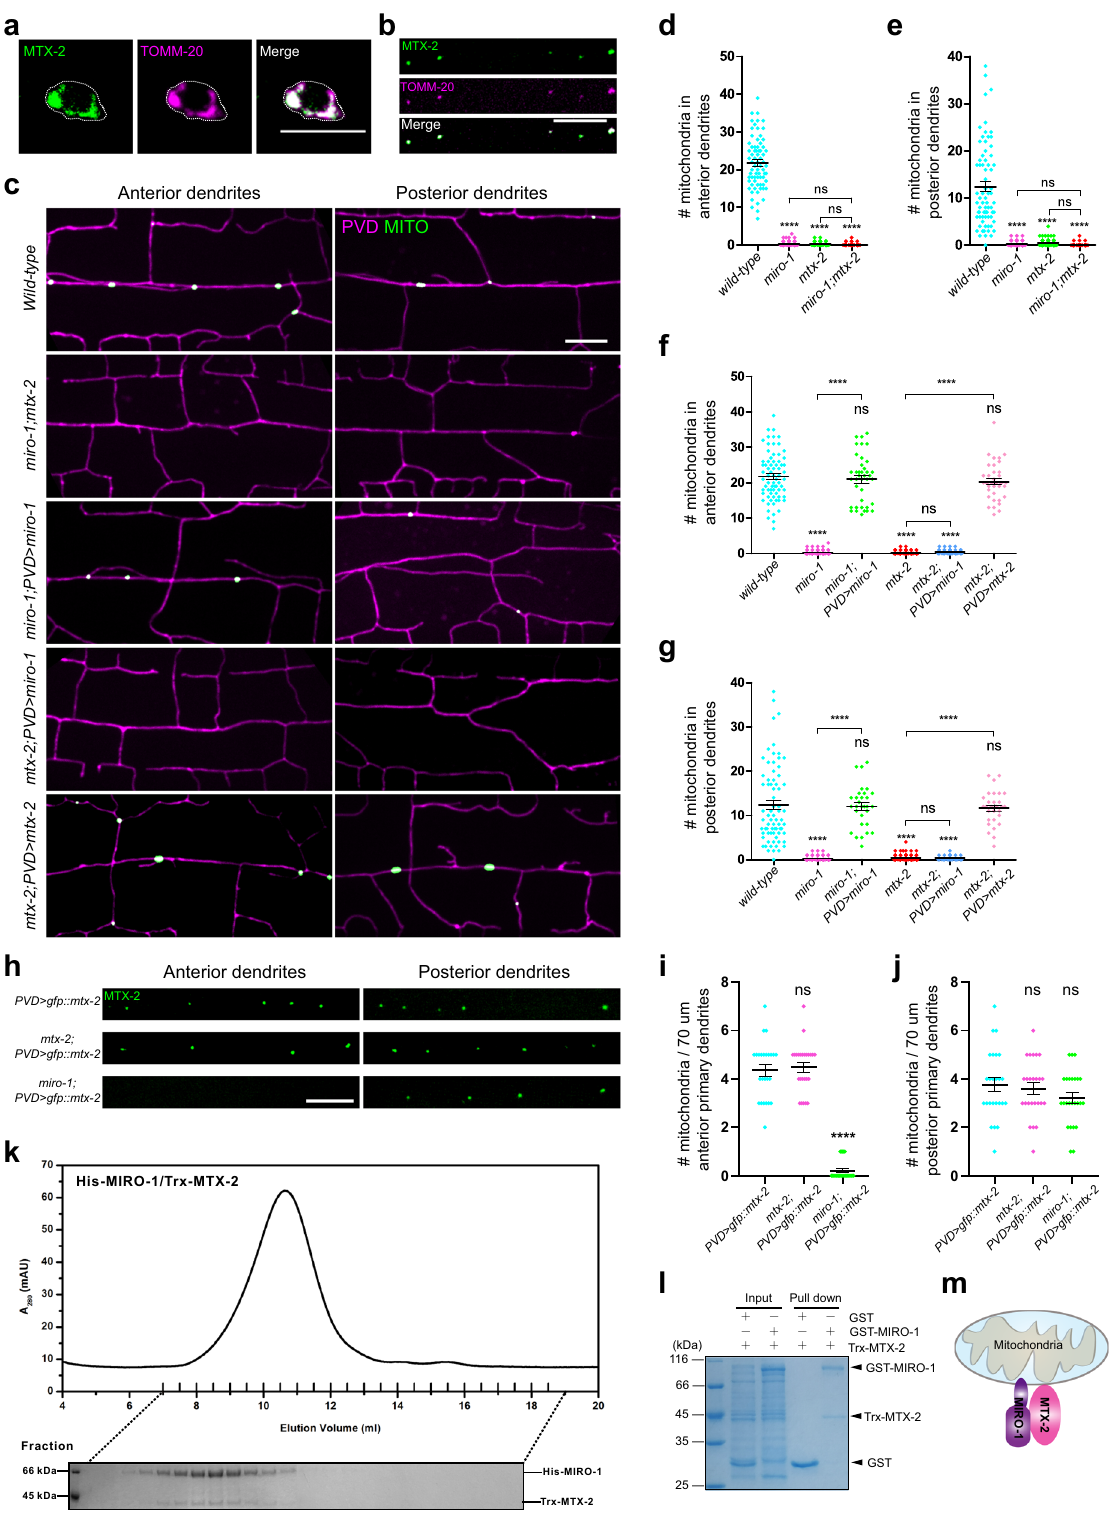
dendrites (Fig. 3a, b). Time-lapse imaging experiments showed out microtubule arrays (MTs), similar to other C. elegans that mtx-1 mutants showed dynamic behavior defects only in dendrites, including the DA9 dendrite. However, posterior PVD posterior dendrites (Supplementary Fig. 4c, d). Western blot dendrites contain plus-end-out microtubules similar to axons in analysis showed that the level of MIRO-1 was not affected by the other worm neurons (Fig. 3c) 28 . Consistently, mtx-1 mutants showed reduced mitochondrial localization in the DA9 axon mtx-1 mutation (Supplementary Fig. 3a – e). (plus-end-out MTs), but normal mitochondrial localization in the The critical difference between anterior and posterior dendrites DA9 dendrite (minus-end-out MTs) (Fig. 3e – h). Together, these in PVD is that anterior dendrites contain exclusive minus-end- NATURE COMMUNICATIONS| (2021) 12:83